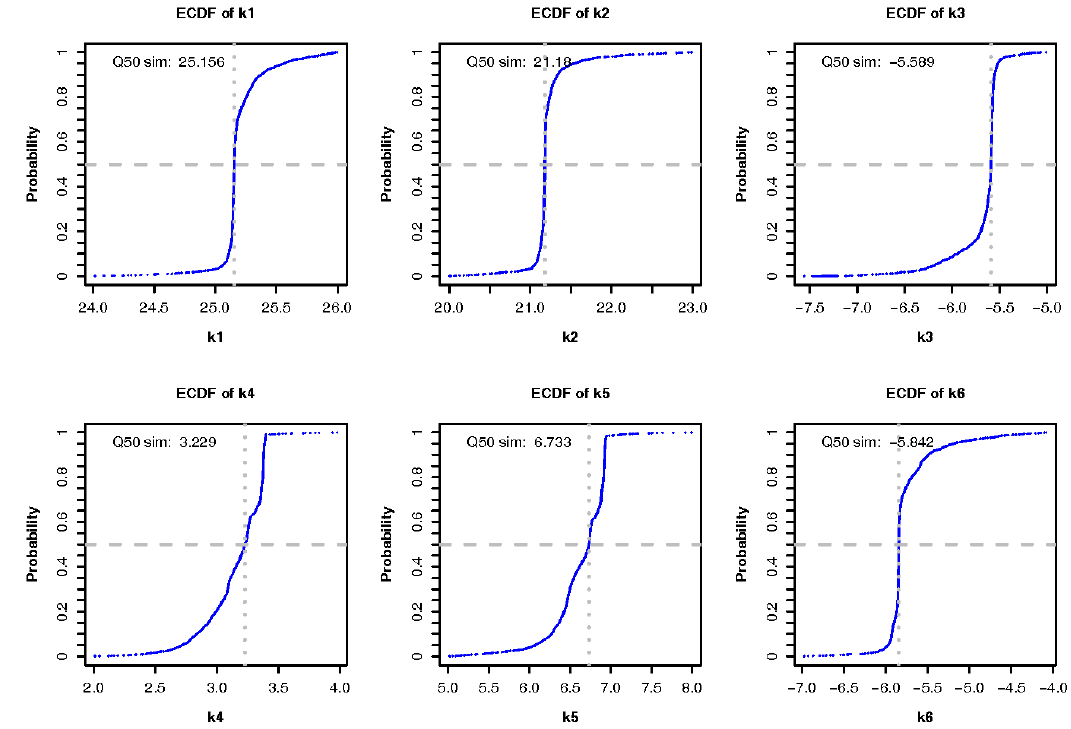
Figure 6. Empirical cumulative density functions for each calibrated parameter.